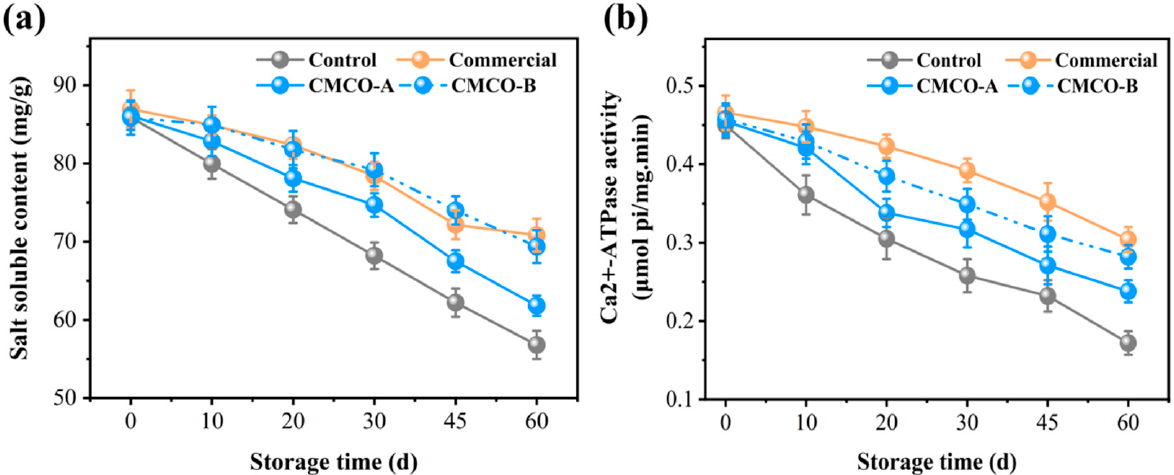
Figure 1. Effects of CMCO on salt-soluble protein content ( a ) and Ca 2+ -ATPase activity ( b ) of MP at different storage time.